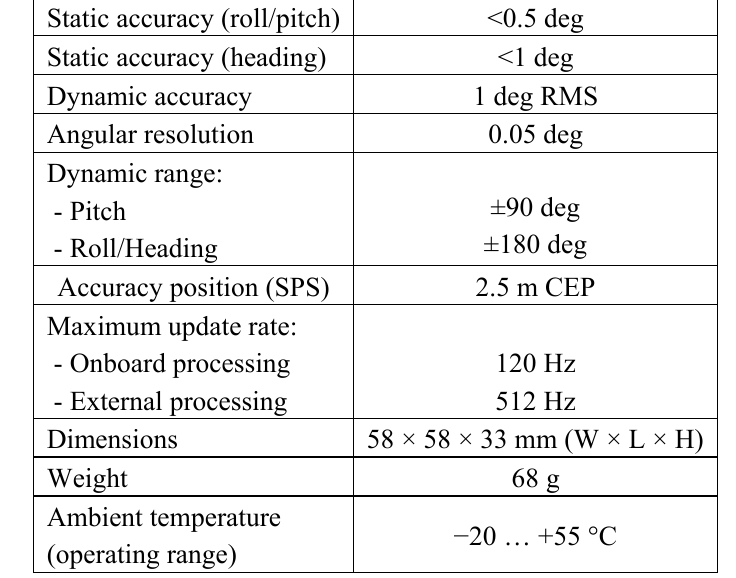
Table 1. Main technical specifications of Xsens